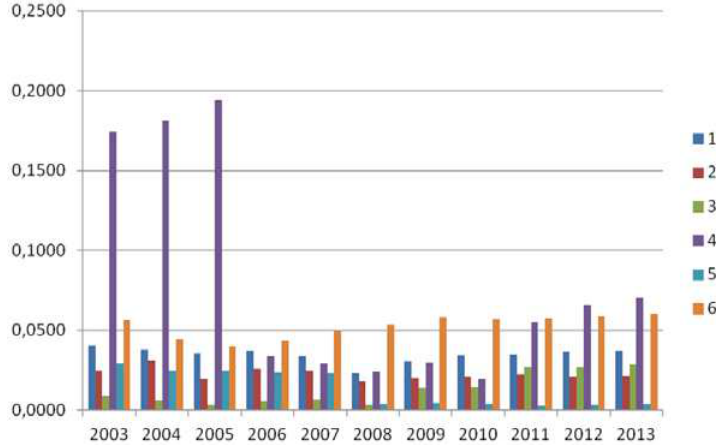
Fig. 1. Intangibles-sector